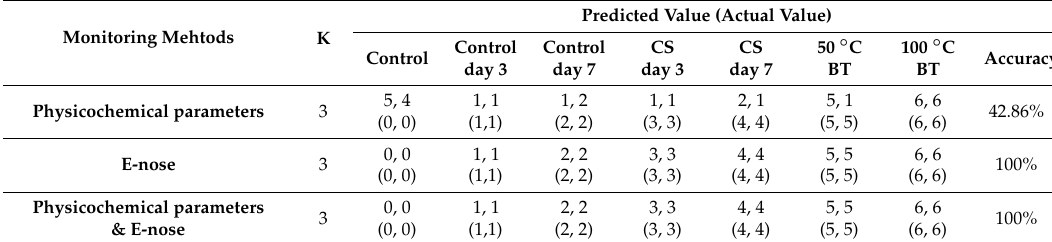
Table 4. KNN monitoring results of validation set of tomato flavor in different postharvest